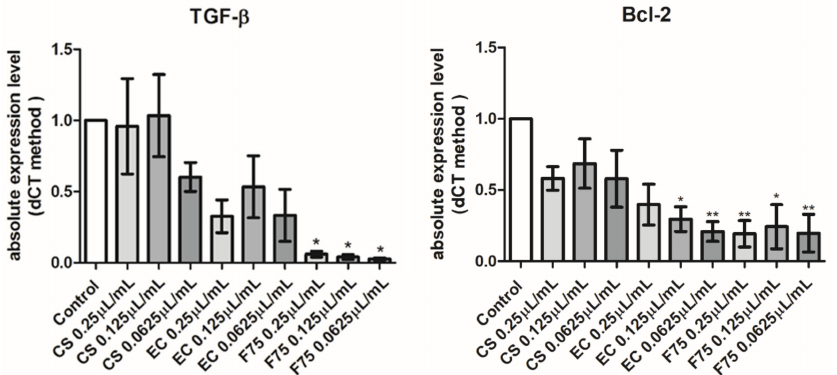
Figure 4. Real-time PCR analyses from three independent experiments (mean ± SEM) of Bcl-2 and TGF- β , in cells treated with vehicle (Control) or 0.25, 0.125, and 0.0625 µ L/mL of essential oils (CS), (EC), and (F75). Differences between groups were evaluated using one-way ANOVA test. Differences